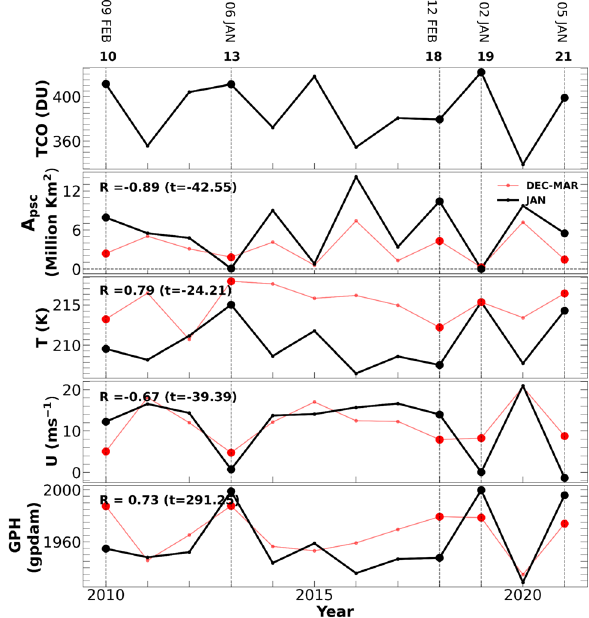
Fig. 6 The temporal evolution of total column ozone (TCO) aver- aged for the months January and February, Polar Stratospheric Cloud (PSC) area (A ), zonally averaged temperature (T, 60°–90° psc N) and winds (U, 60°–90° N) and the geopotential height (GPH, 60°– 90° N). Here, the PSC area is for 460 K, and all the other variables are for 50 hPa. The top panel shows TCO. The horizontal dashed line shows the zero value of the variables and the vertical lines cor- respond to years with SSWs, the central date of occurrence of the warming is indicated in the top